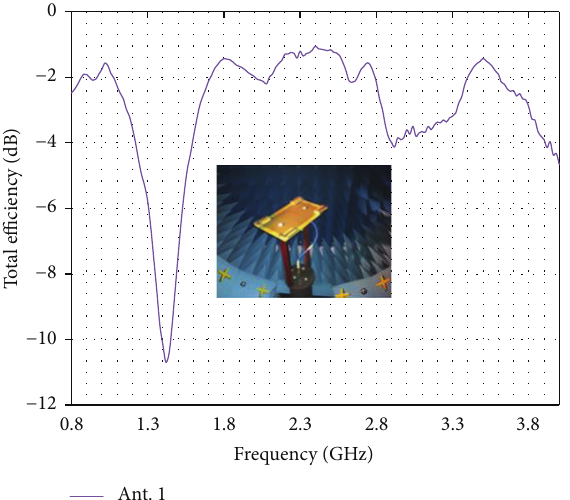
Figure 13: Measured total efficiency of the realized